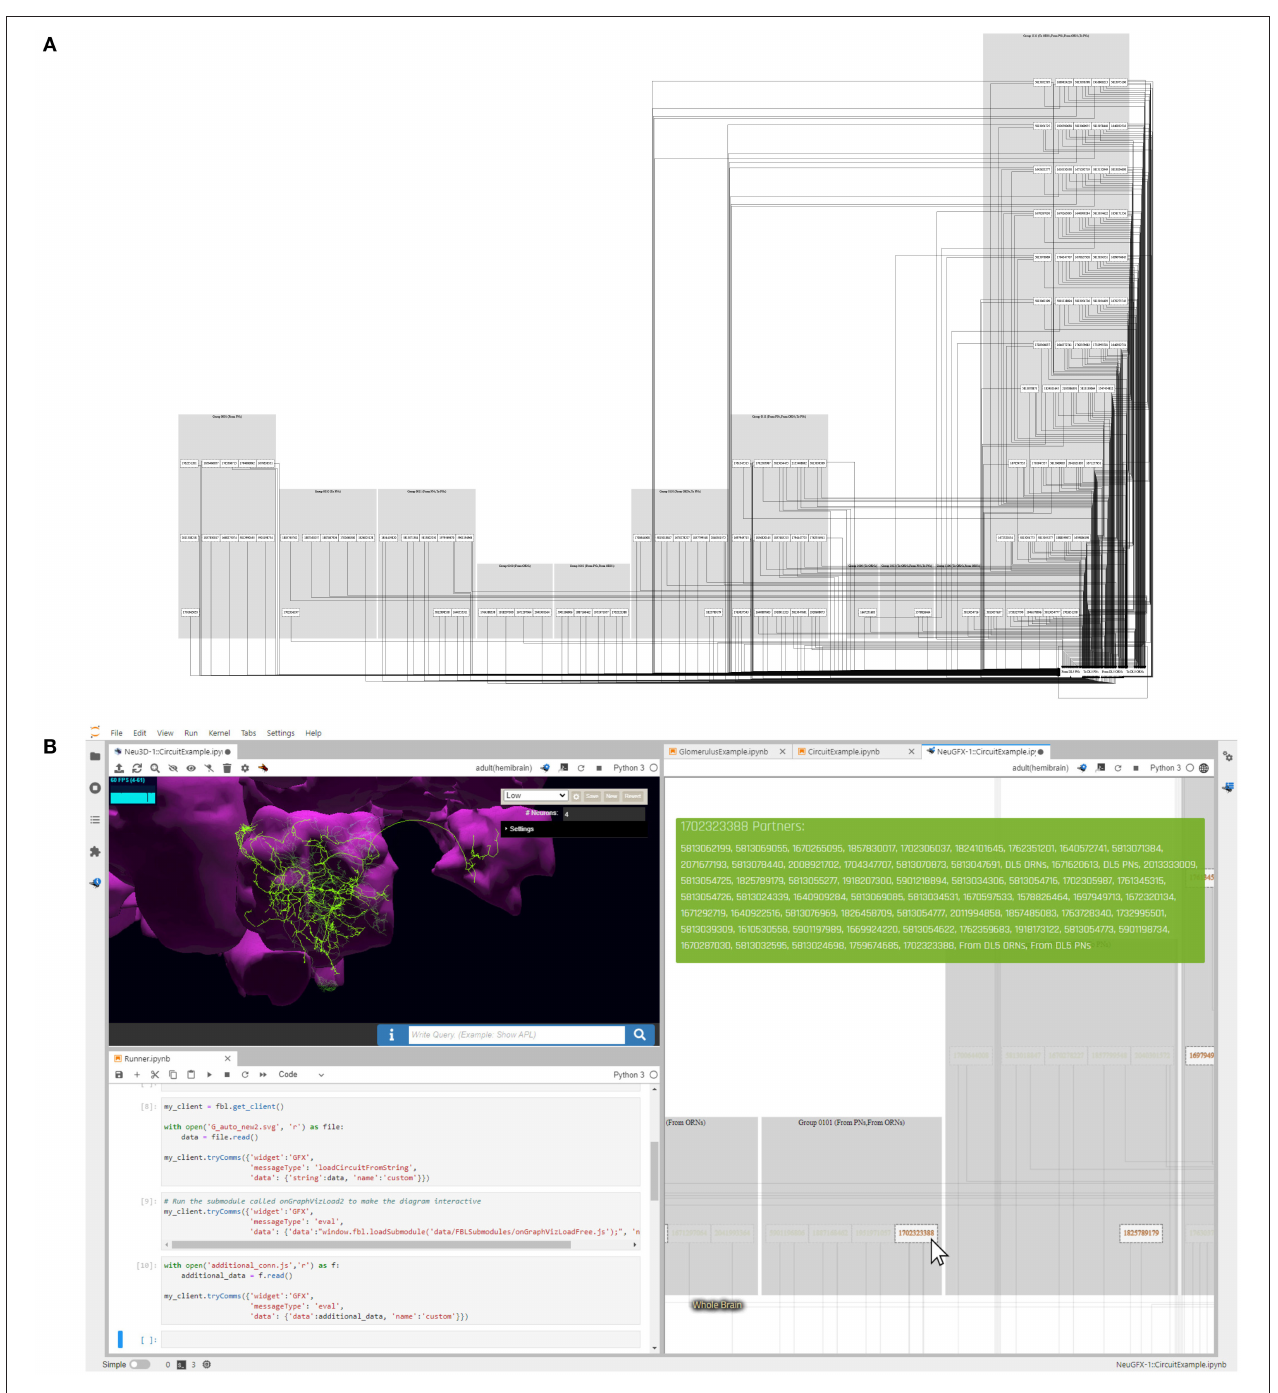
FIGURE 13 | Exploring the feedback loops between the DL5 and DM4 glomeruli using an interactive circuit diagram generated by the FeedbackCircuits Library. (A) Users can generate a circuit diagram for any glomerulus consisting of OSNs, PNs, and LNs grouped according to the feedback connectivity pattern described in Figure 7E , such as the diagram here for the DL5 glomerulus. (B) The generated diagrams are interactive in the FlyBrainLab platform. Hovering over the neurons on the diagram (right) shows their partners, and highlights them in the diagram and in the corresponding 3D morphology (top left); clicking disables/enables them for program execution (bottom left). Here, the user is currently hovering over the Hemibrain neuron with identifier 1702323388, which shows its partners in the green block on the top right window and highlights it on the morphology in the top left in green.